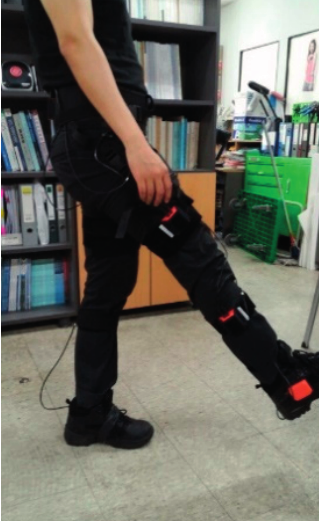
Figure 3. Lifting the right leg for the calibration process. The subjects is asked to perform the motion three times each for both